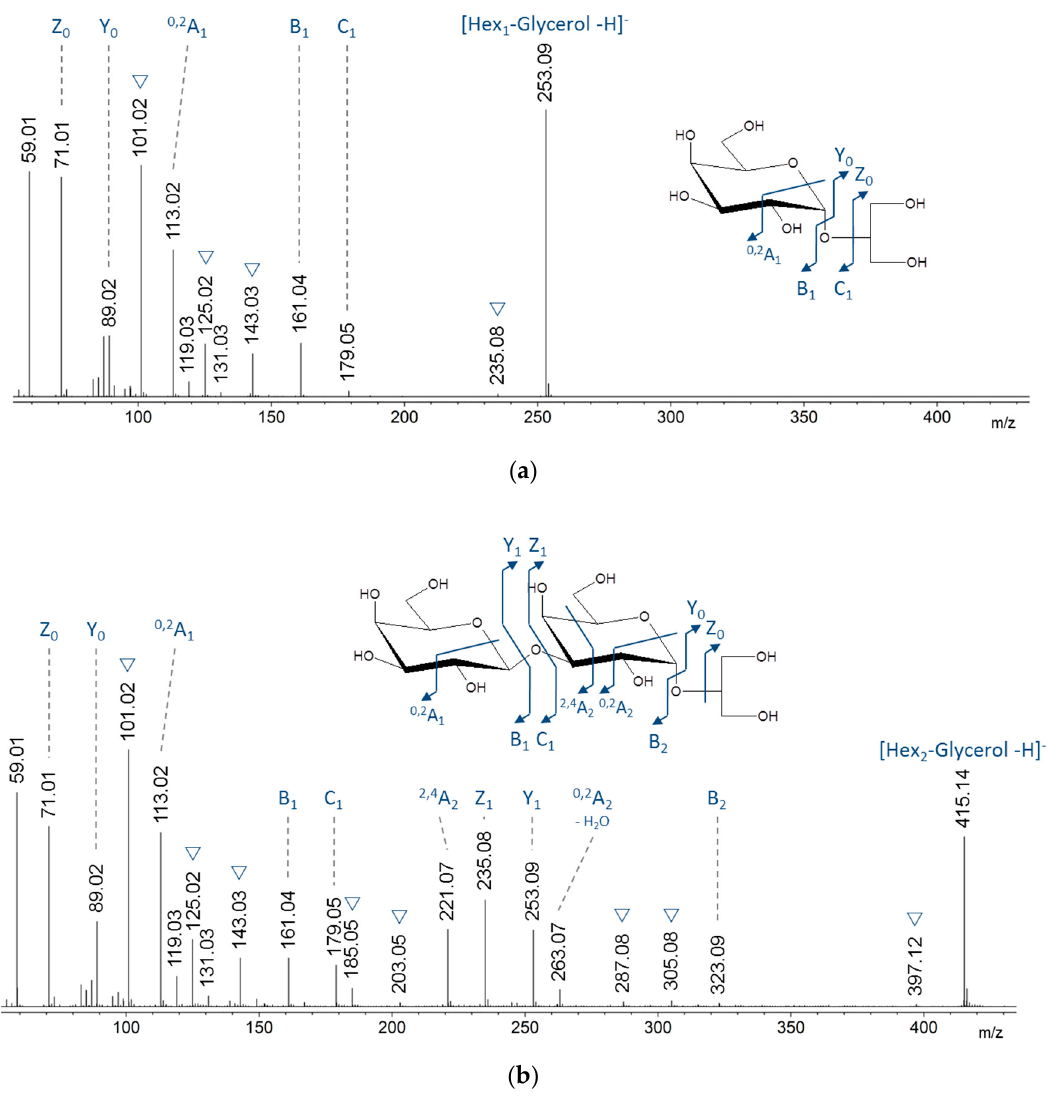
Figure 3. ESI-MS/MS ( − ) spectra of the hexose-glycerol ( a ) and the (hexose) 2 -glycerol ( b ) observed at m / z 253.09 and m / z 415.14, respectively. (cid:53) : Water losses.